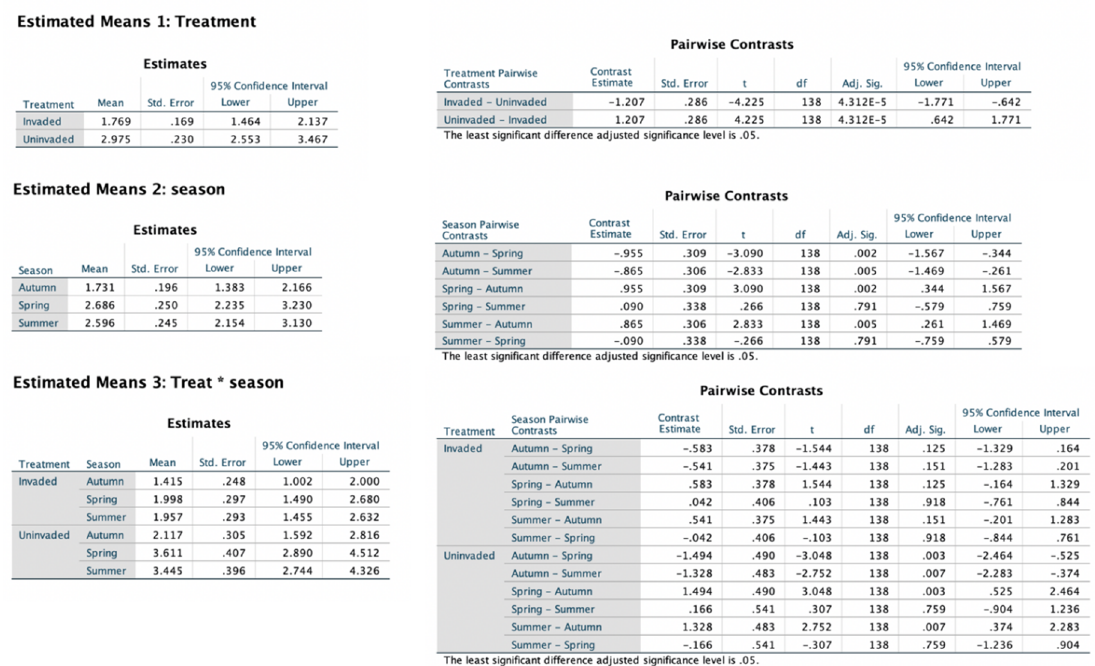
Figure A3. Results for the GLMM’s estimated marginal means, showing the pairwise combinations of treatments (invaded/uninvaded orchards) and seasons (summer, autumn, spring).